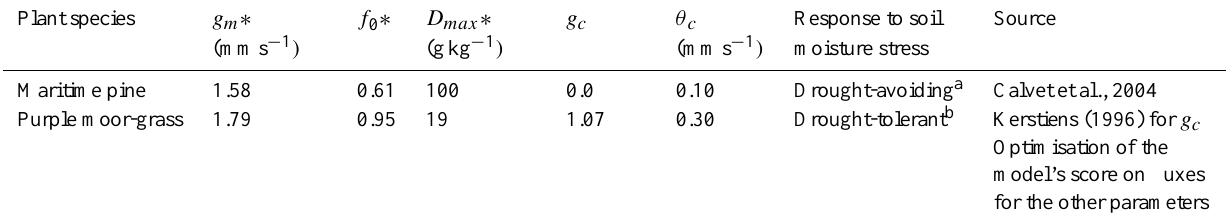
Table 3. Values of the parameters for the trees and undergrowth of Le-Bray. Note that g m is the mesophyll conductance, f 0 the maximum potential value of the ratio between internal and external leaf concentration of CO 2 , D max the maximum value of air saturation deficit (* denotes unstressed soil moisture conditions), g c the leaf cuticular conductance and θ c the critical extractable soil moisture.